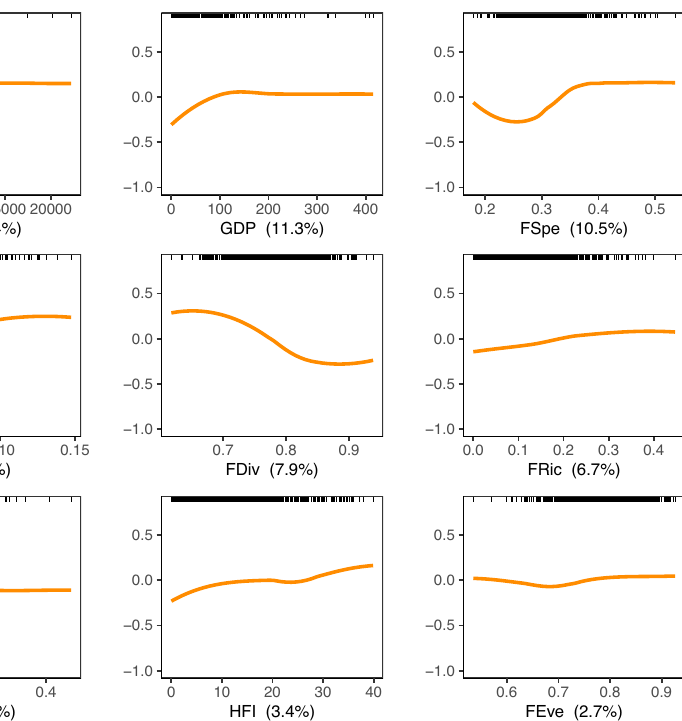
values. cd centroid distance, Area watershed area, GDP gross domestic product, FSpe functional specialization, NPP net primary productivity, md mean distance, FDiv functional divergence, FRic functional richness, FOri functional originality, DOF degree of river fragmentation, HFI human footprint index, FEve functional